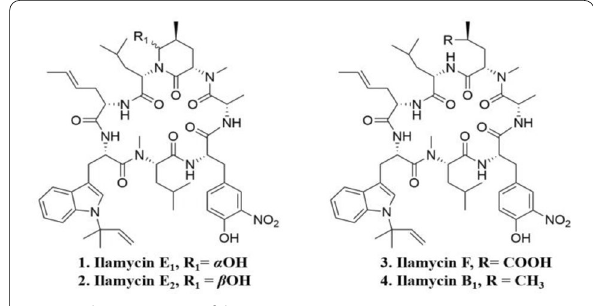
Fig. 1 The structures of